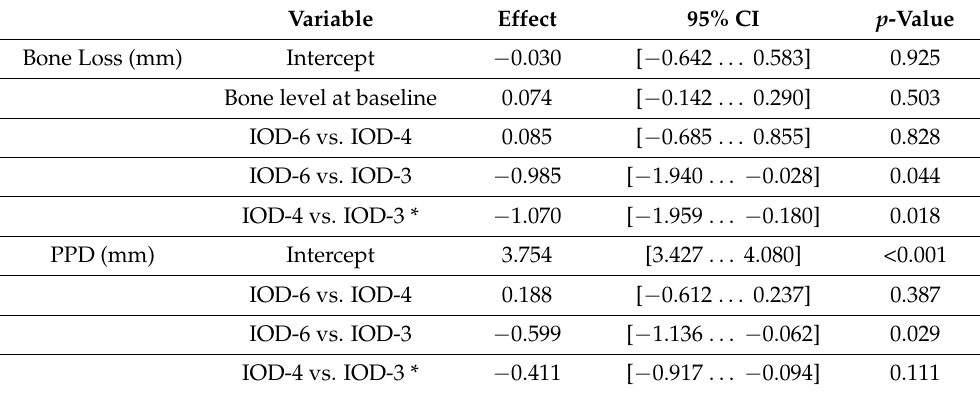
Table 2. Table demonstrating the effect of suprastructure on bone loss and probing pocket depth (PPD). IOD-6 used as the reference for the mixed model analysis. When comparing IOD-6 to IOD-3, a statistically significant difference was seen for the effect of the suprastructure on the bone level ( p = 0.044), as well as on PPD ( p =